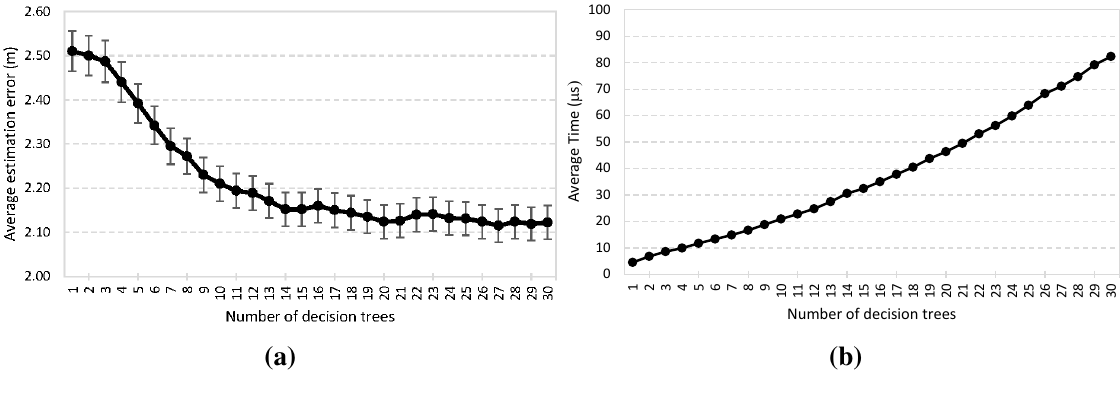
Figure 7. Effect of the multiple decision trees: ( a ) average estimation error; ( b ) elapsed